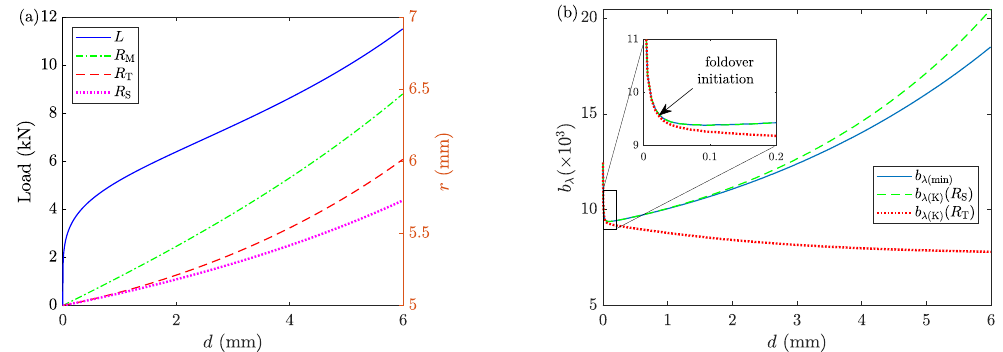
Figure 10. The results of Case 2. ( a ) The deformation load (left y -axis) and the sample’s geometry (right y -axis) as functions of displacement d . ( b ) The values of b λ obtained from the minimization process ( b λ (min) ) and the kinematics estimation ( b λ (K) ) from Equation (28) for two values of R (cid:3) : R S and R T . The zoomed-in inset shows that the b λ (K) ( R T ) underestimates the barreling parameter from the onset of the foldover phenomenon.